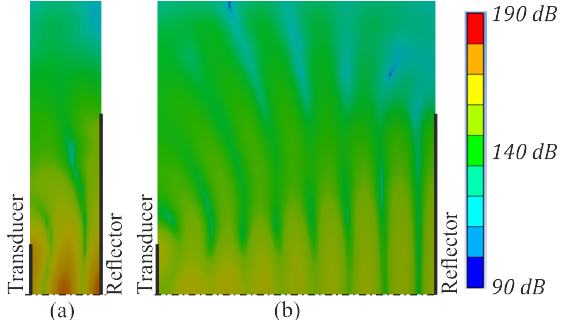
Figure 3. Sound field pattern between transducer and a plain reflector at distances of L = 17 mm ( a ) and L = 66.4 mm ( b ); maximum pressure level points marked with x; f = 21.4 kHz; ˆ x = 19 µ